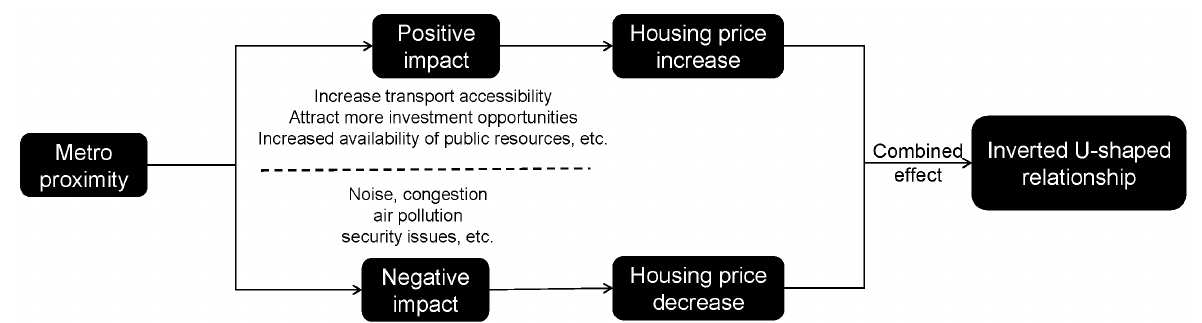
Figure 5. The influence mechanism of subway accessibility on housing prices. OLS reveals the relationship between independent variables and conditional expec- tation of dependent variables, while quantile regression reveals the relationship between independent variables and conditional quantiles of dependent variables, thus revealing the influence of independent variables on dependent variables at different levels. In other words, quantile regression provides an effective way to study the heterogeneous effects of rail transit on different housing prices. The impact of subway station proximity on higher quantile of housing prices means the impact of transport accessibility on the high- priced housing. The OLS regression results (Equation (6)) showed that the coefficient of d2 was 0.078, while the quantile regression results (Equation (8)) showed that d2 was 0.092, 0.081, and 0.056 in 25%, 50%, and 75% quantiles, respectively. Therefore, OLS esti- mates actually underestimate the impact of rail transit proximity on low-and middle- priced housing and overestimate the impact on high-priced housing. This further demon- strates the necessity for quantile regression. The quantile results show that the influence